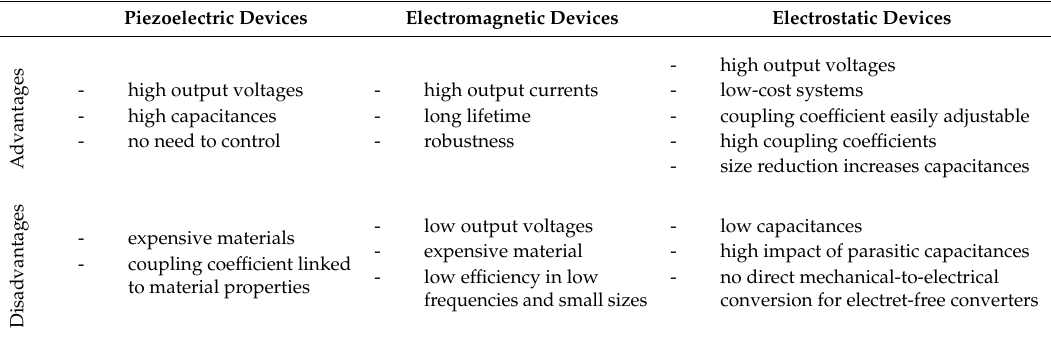
Table 3. Comparison of various vibrational-harvesting